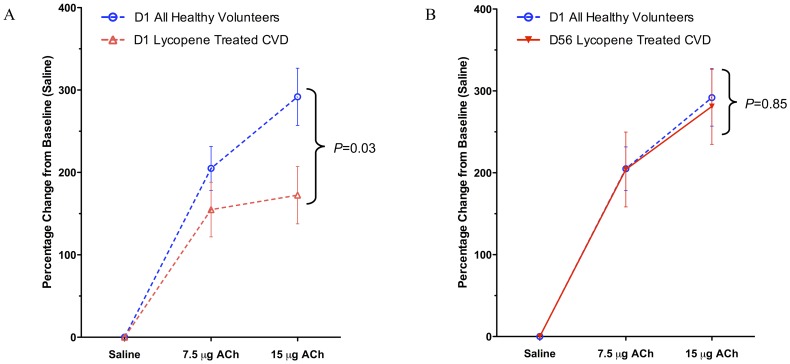
Post-hoc analysis of infused arm FBF values in response to ACh.Forearm blood flow (FBF) values are represented as percentage change from preceding saline baseline with standard error bars. P-values were generated from comparisons made using unpaired, 2 tailed Student t-tests. (A) At the start of the study, patients with cardiovascular disease (CVD) in the lycopene group (broken red line) had significantly impaired vasodilatory responses to acetylcholine (ACh; 30% lower, 95%CI: −58% to −3%, P = 0.03) compared with healthy volunteers (HVs) at baseline (broken blue line). (B) After treatment with lycopene, the same patients (solid red line) show no significant changes in FBF values compared with HVs at baseline (broken blue line) (2% lower, 95% CI: −30% to +30%, P = 0.85).